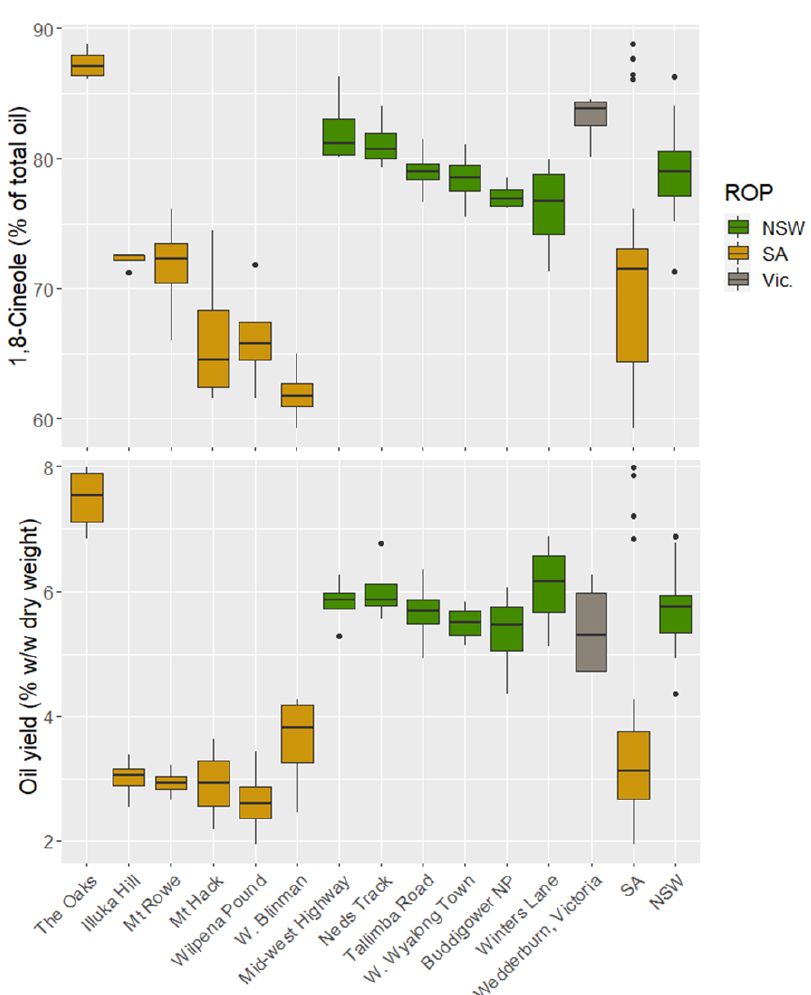
Figure 3. Box plots showing: boxes the mean andinterquartile range; whiskers the extent of the 0th and 100th percentiles, and; dots outlying values for oil yield and %cineole traits by provenance and ROP.